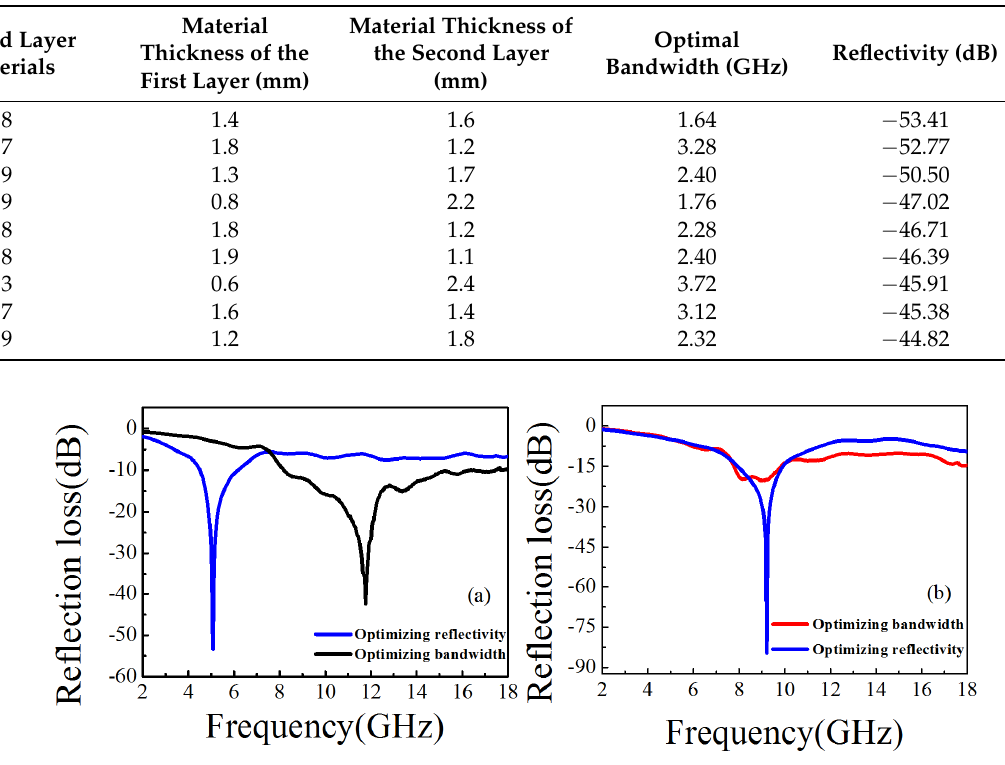
Frist Layer Materials